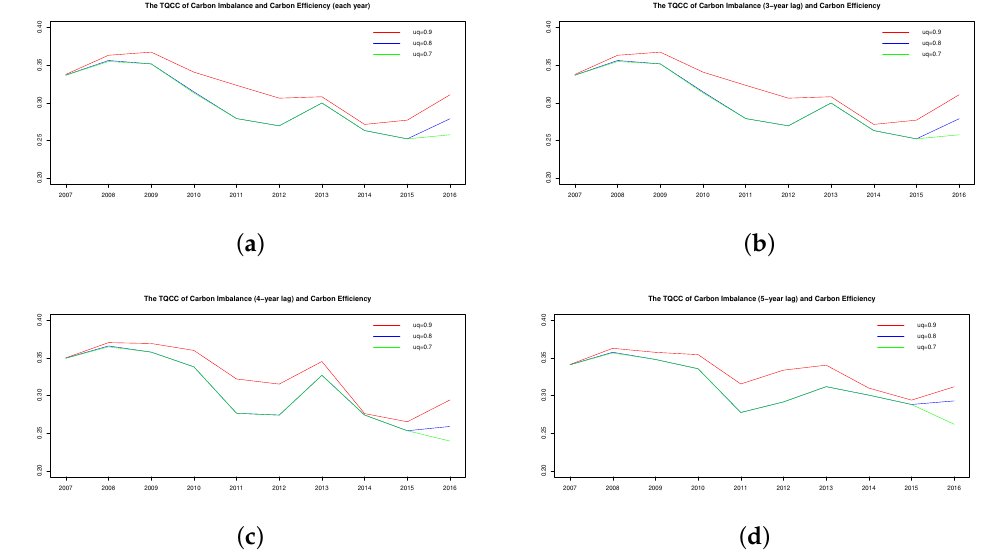
Figure 3. The TQCC estimation between RCI and regional carbon efficiency from 2007 to 2016 with uq = 0.9,0.8 and 0.7 based on: ( a ) TQCC for each year; ( b ) TQCC based on 3-year rolling window; ( c ) TQCC based on 4-year rolling window; ( d ) TQCC based on 5-year rolling window. Note: The figure displays the TQCC results based on the annual original data in panel ( a ) and the rolling window of 3, 4, and 5 years in panels ( b – d ), respectively. In each panel, we use uq with 0.9, 0.8, and 0.7 quantiles to calculate the TQCC. The TQCC patterns are almost the same in all panels regardless of the thresholds, which demonstrates the robustness of the